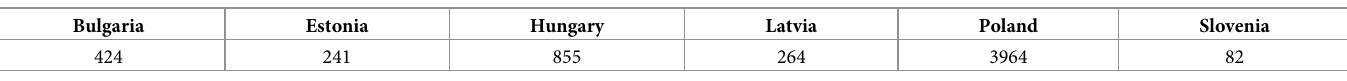
Table 1. Number of farms covered by this study (by